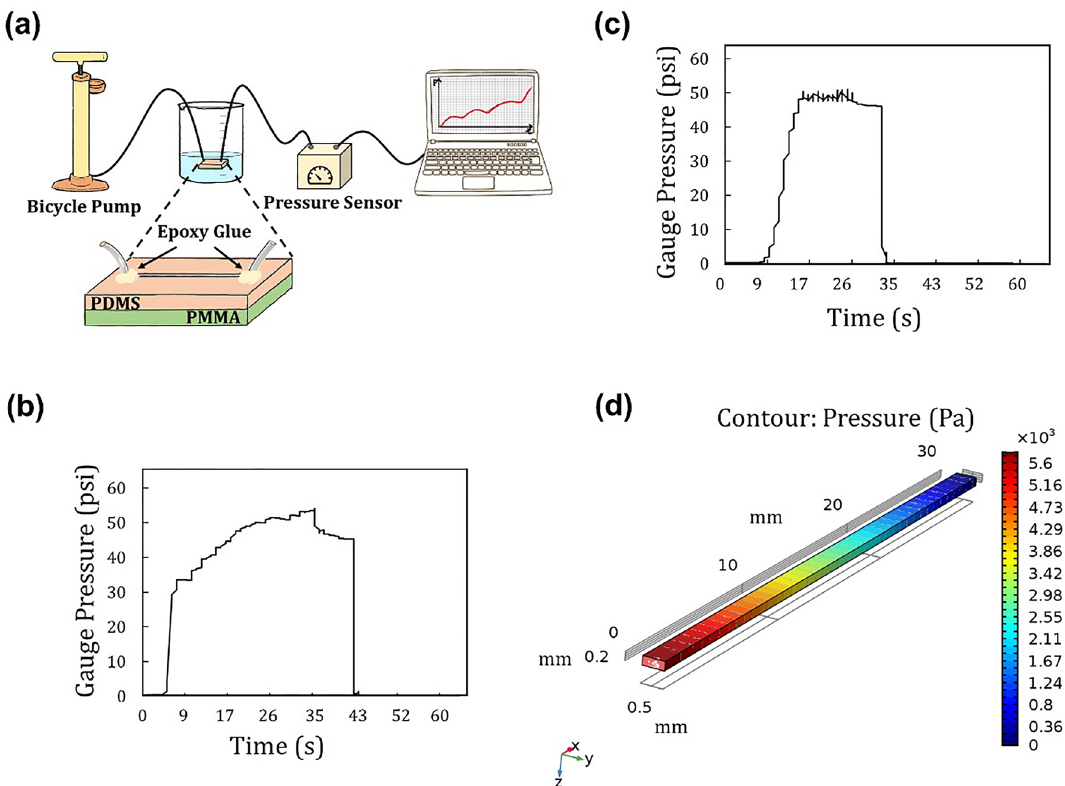
Figure 6. Burst pressure test of PDMS–PSA–PMMA bond (experimental set-up and results) and COMSOL simulation of leakage test. ( a ) The experimental set-up for a burst pressure test. Burst pressure test result is shown in ( b ) straight and ( c ) serpentine microchannels. The PDMS–PSA bond endured a pressure of approximately 50 psi while the pressure dramatically dropped not due to the bond failure, but rather